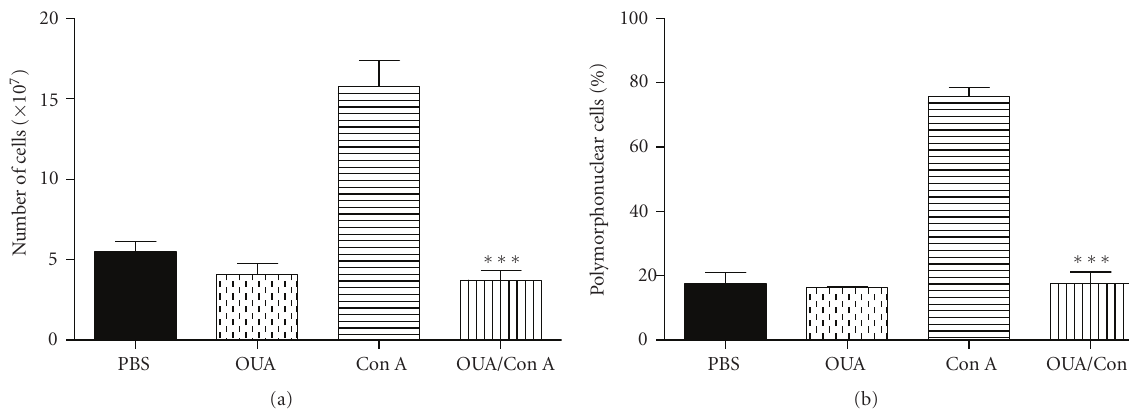
Figure 4: E ff ect of the pretreatment with Ouabain (OUA, 0.56mg/kg) administered intraperitoneally on peritoneal inflammation triggered by Concanavalin A (ConA, 60 μ g/300 μ L) on total (a) and di ff erential cell counts (b). Each bar represents the mean of nine animals. Asterisks denote the significance levels compared with Con-A values. Data were expressed as mean ± S.E.M. and analyzed by software Graphpad Prism using Student’s t -test followed by unpaired test ∗∗ P < . 01 and ∗∗∗ P < . 001.